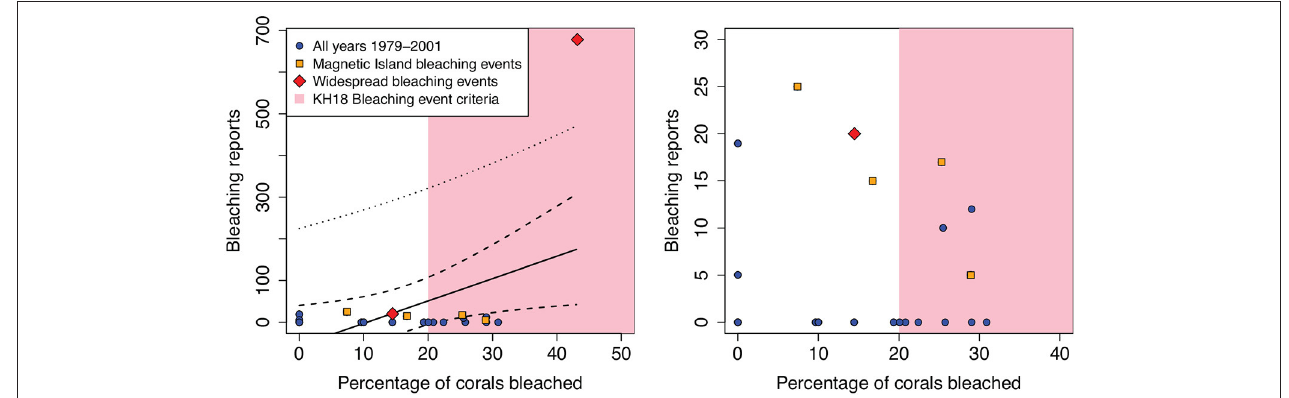
FIGURE 1 | Comparison of bleaching reports and KH18’s proxy-based percentage of corals bleached, per year between 1979 and 2001. The data were extracted directly from Figure 3 of KH18. Years with described bleaching events, both localized and widespread (see text for references), are shown with orange squares and red diamonds, respectively. The pink shaded background indicates KH18’s 20% of corals bleached threshold for defining a widespread bleaching event. The best-fit line (solid black), standard error of the curve (dashed black), and standard error of prediction (dotted black) are shown for a regression between bleaching reports and percentage of bleaching corals. The right panel shows the same data, but zoomed in to show all years except